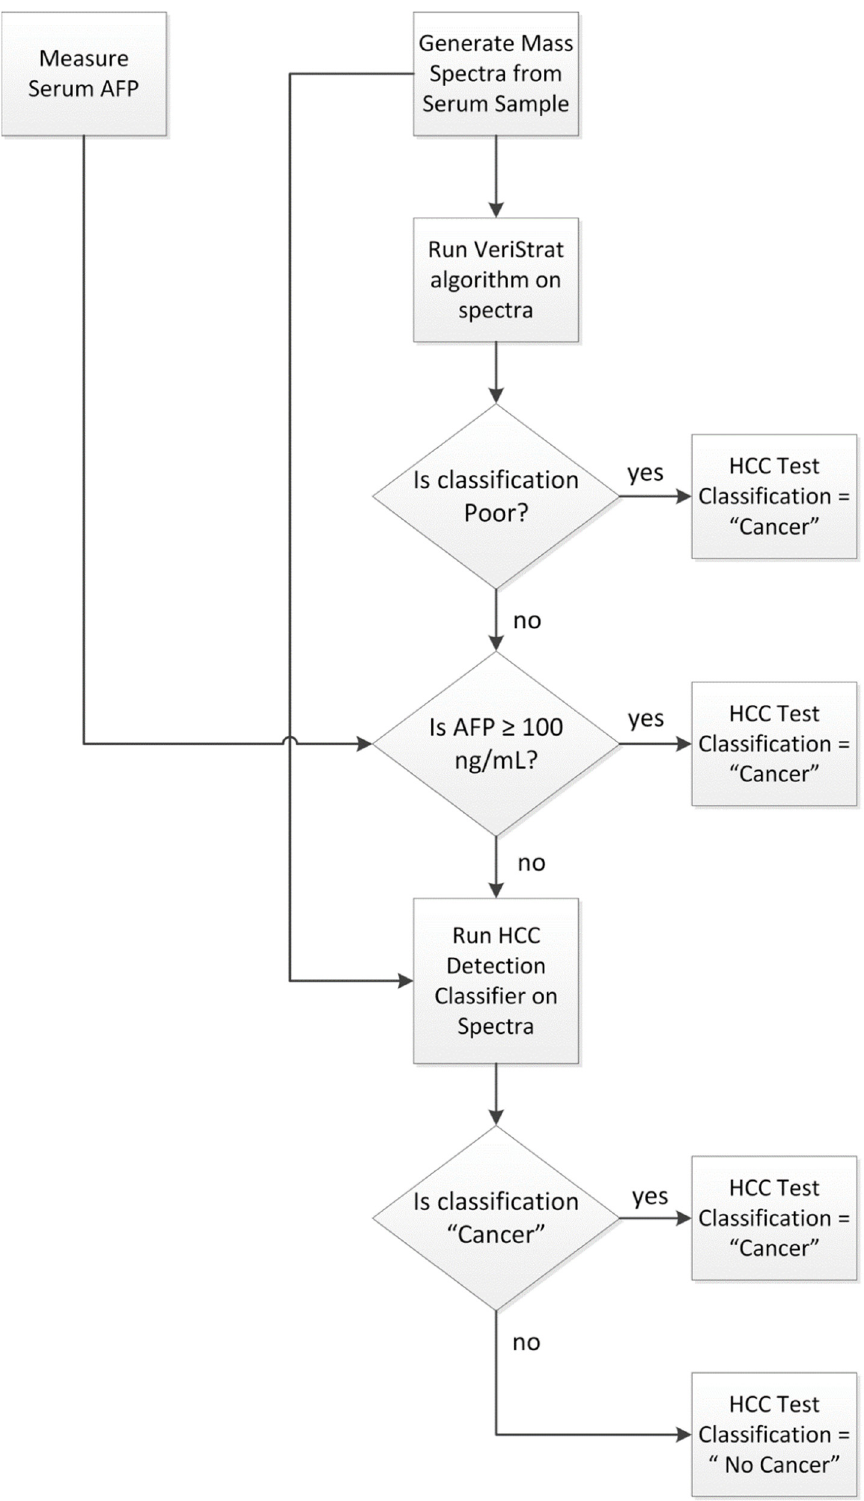
Figure 3. Classification algorithm for the HCC Detection Test .